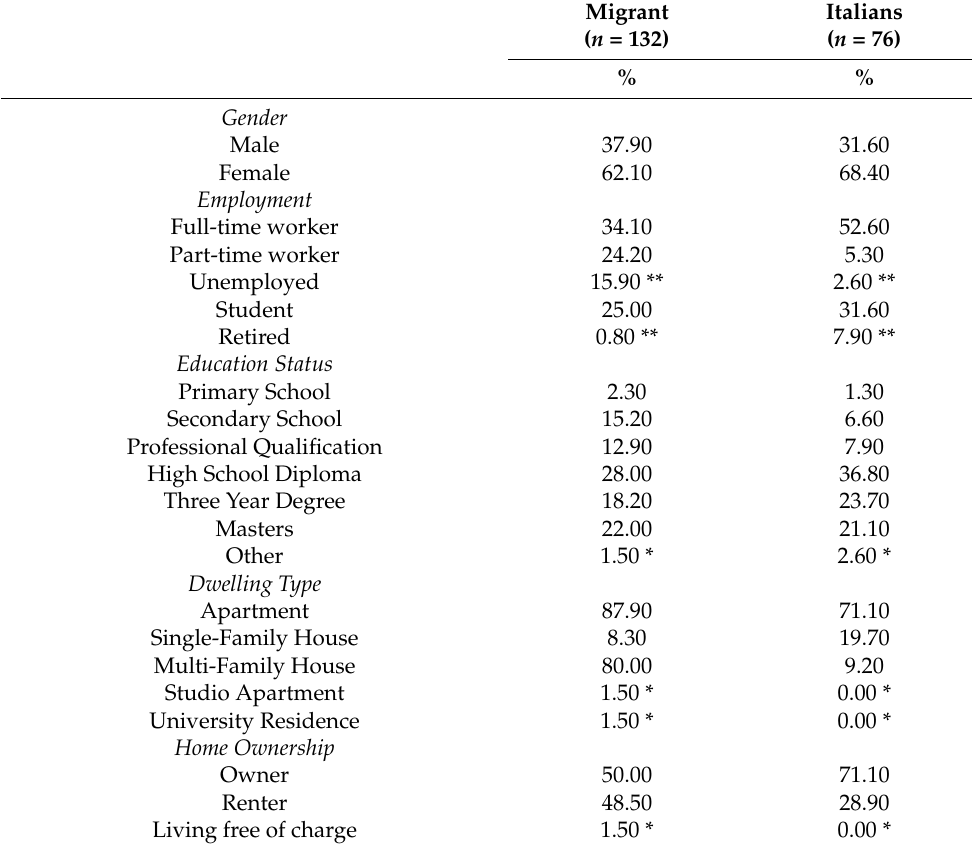
Table 1. Percentages by Demographic